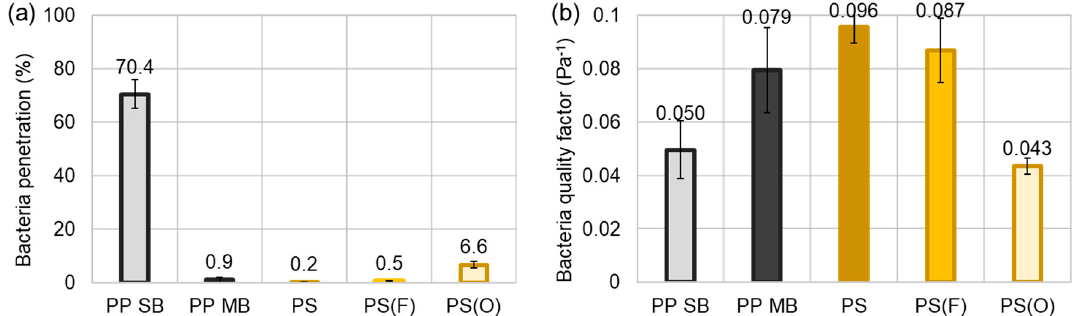
Figure 6. S. aureus bacteria filtration. ( a ) % Penetration; ( b ) Quality factor. Note: PP SB is two layers of PP SB.